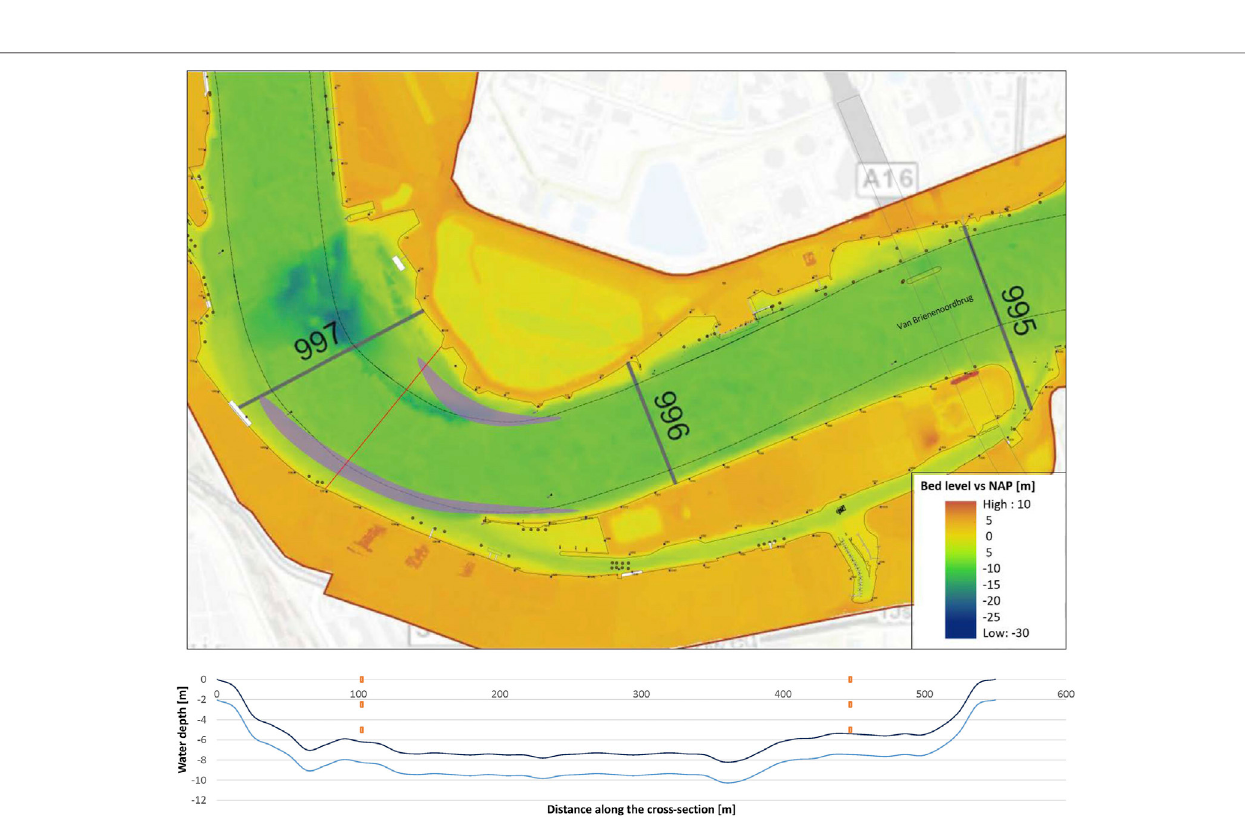
Frontiers in Environmental Science |